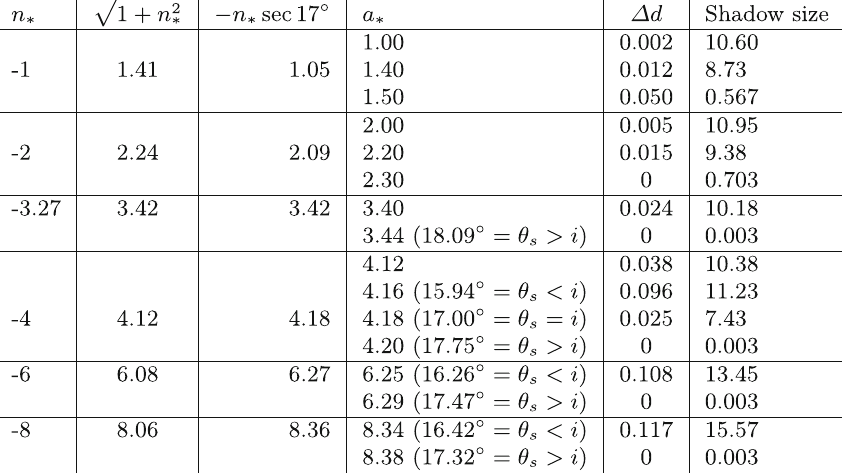
Table 1 The shadow size starts to decrease rapidly for crossing a ∗ = − n ∗ sec17 ◦ (or, a ∗ = − 1 . 046 n ∗ ), not for crossing a ∗ = whichisvalidforthevaluesof n ∗ : n ∗ < − 3 . 27.Incontrast,theshadow size suddenly becomes very small due to crossing a ∗ = the values of n ∗ : 0 > n ∗ > − 3 . 27 (similar to the case for Kerr